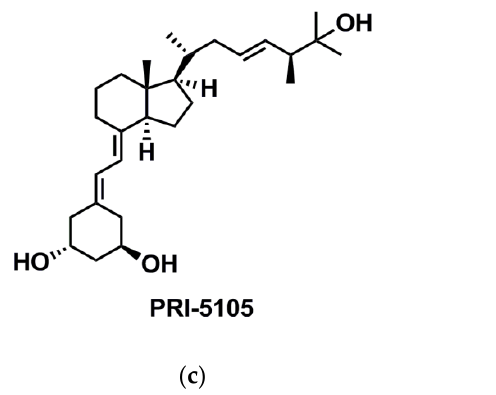
( c ) ( d ) Figure 1. Structures of the analogs studied in this paper. ( a ) Paricalcitol, PRI-5100 ( 1R,3R,7E,22E,24S )-24-methyl-19- nor -9,10-secocholesta-5,7,22-triene-1,3,25-triol; ( b ) PRI-5101 ( 1R,3R,7E,22E,24R )